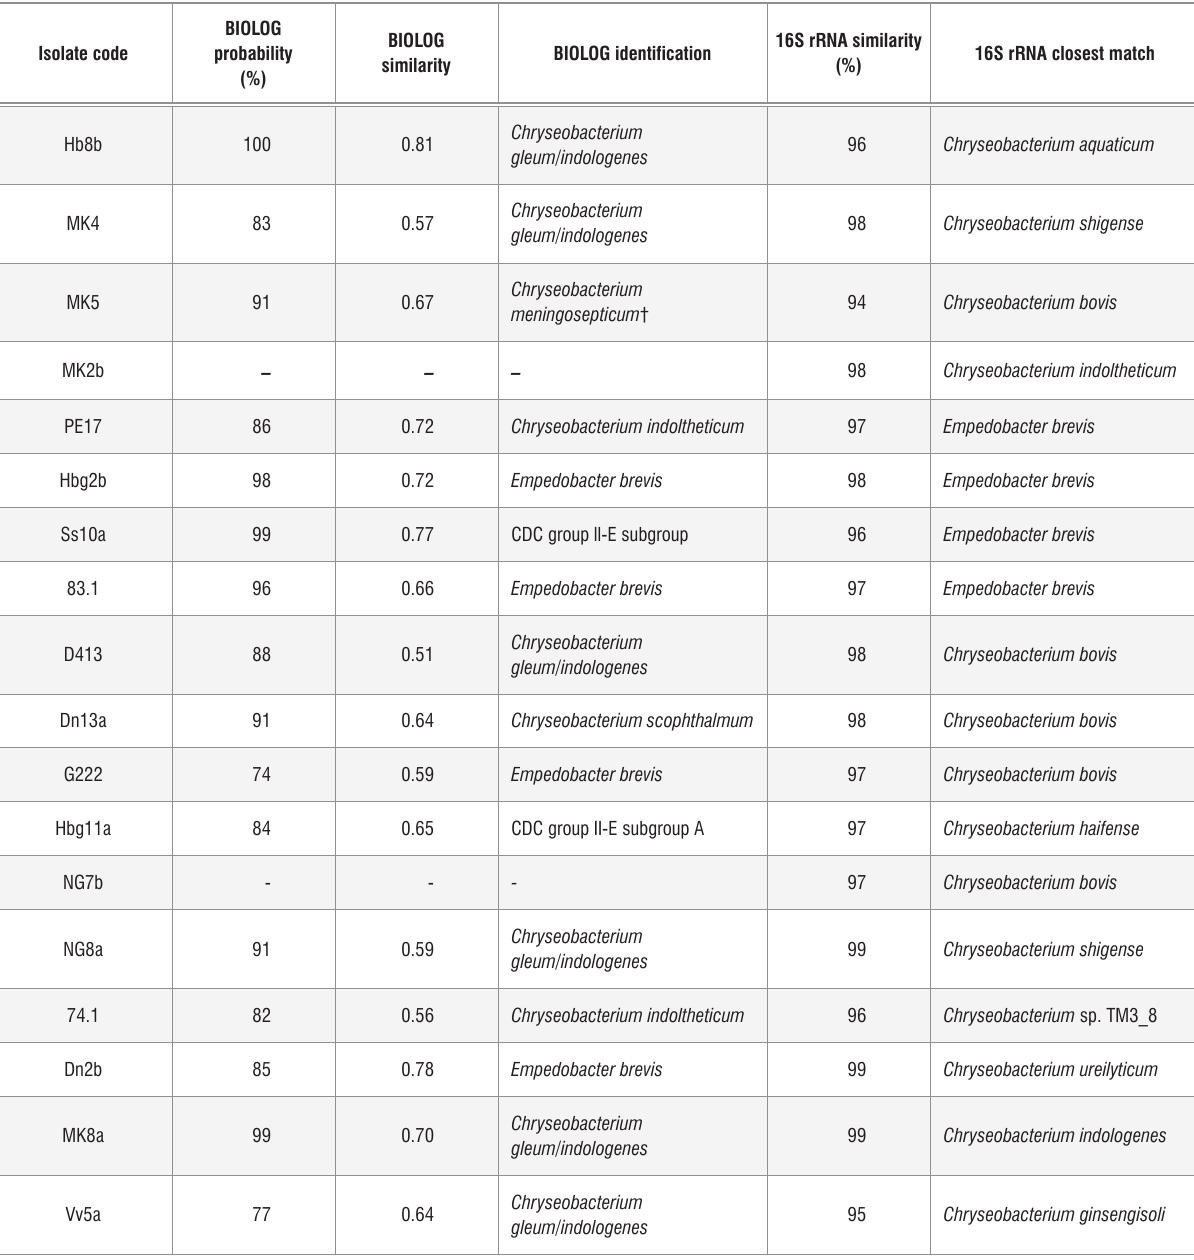
Table 3: Identification of flavobacterial strains with the BIOLOG system after 24h of incubation and 16S rRNA similarity and identification BIOLOG BIOLOG Isolate code probability BIOLOG similarity (%)